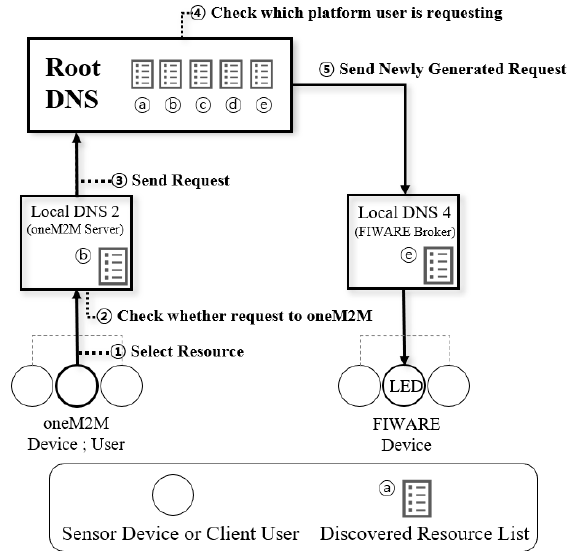
Figure 13. Scenario 2: A oneM2M request to a FIWARE.